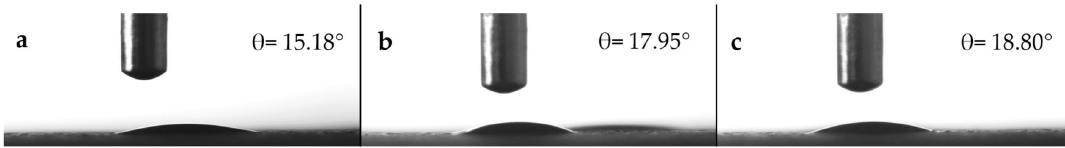
Figure 11. Increase of the contact angle for a separation of 0.3 mm and: ( a ) 5000 mm/min; ( b ) 7000 mm/min; ( c ) 9000 mm/min.